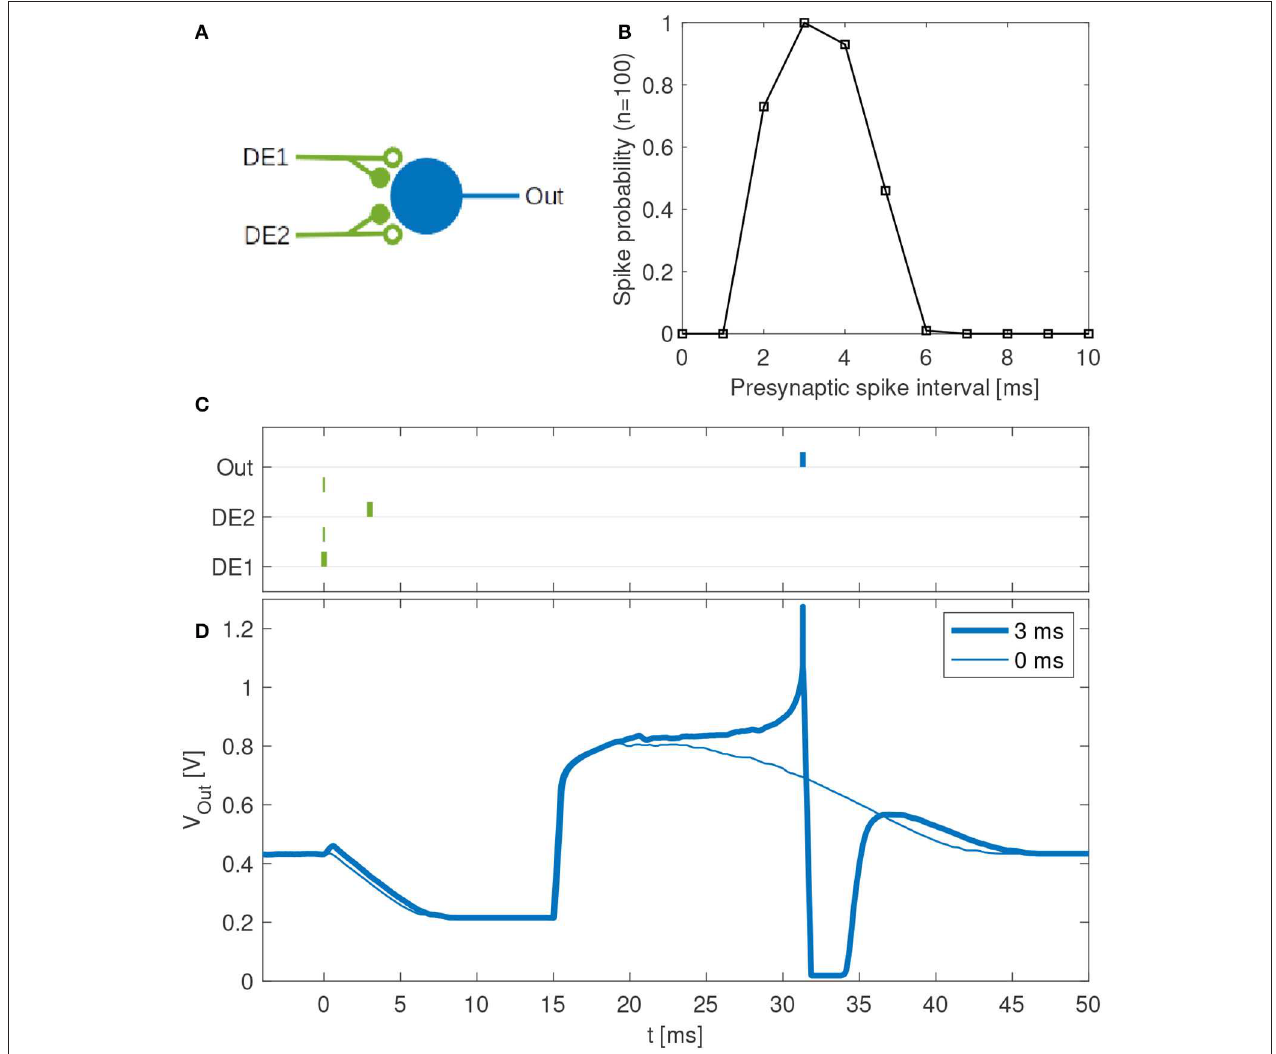
FIGURE 10 | Feature detection by a single neuron in the DYNAP-SE. (A) Neuron with one output (Out) and two inputs with disynaptic delay elements (DE1 and DE2). (B) Probability that the neuron spikes vs. the presynaptic spike interval, which denotes the time between two presynaptic spikes at DE1 and DE2, respectively. This neuron spikes with maximum probability when a spike arrives to DE2 about 3 ms later than to DE1. The neuron does not spike for presynaptic spike intervals below about 2 ms and above about 6 ms. (C) Examples of spike times for presynaptic spike intervals of 3 ms (bold lines) and 0 ms (thin lines). In the latter case no postsynaptic spike is generated. (D) Examples of membrane potentials measured for 3 ms (bold line) and 0 ms (thin line) presynaptic spike intervals. No spike is generated when the two presynaptic spikes arrive simultaneously. With a presynaptic spike interval of 3 ms the neuron spikes